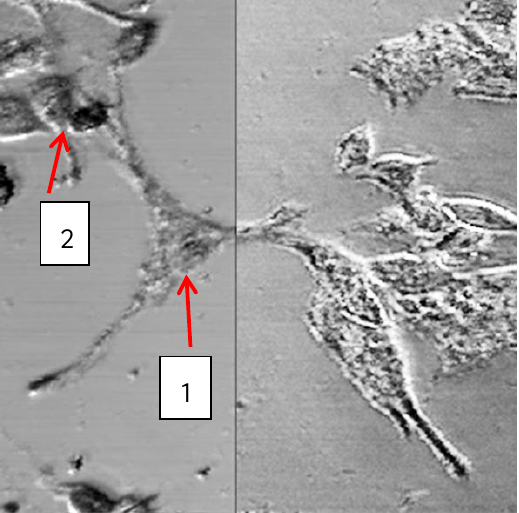
Figure 11. Image of human melanoma cells. In the left half the image at 1,064 nm wavelength, in the right half at 550 nm. Lateral dimensions 400 μm. Cells considered for analysis are indicated by